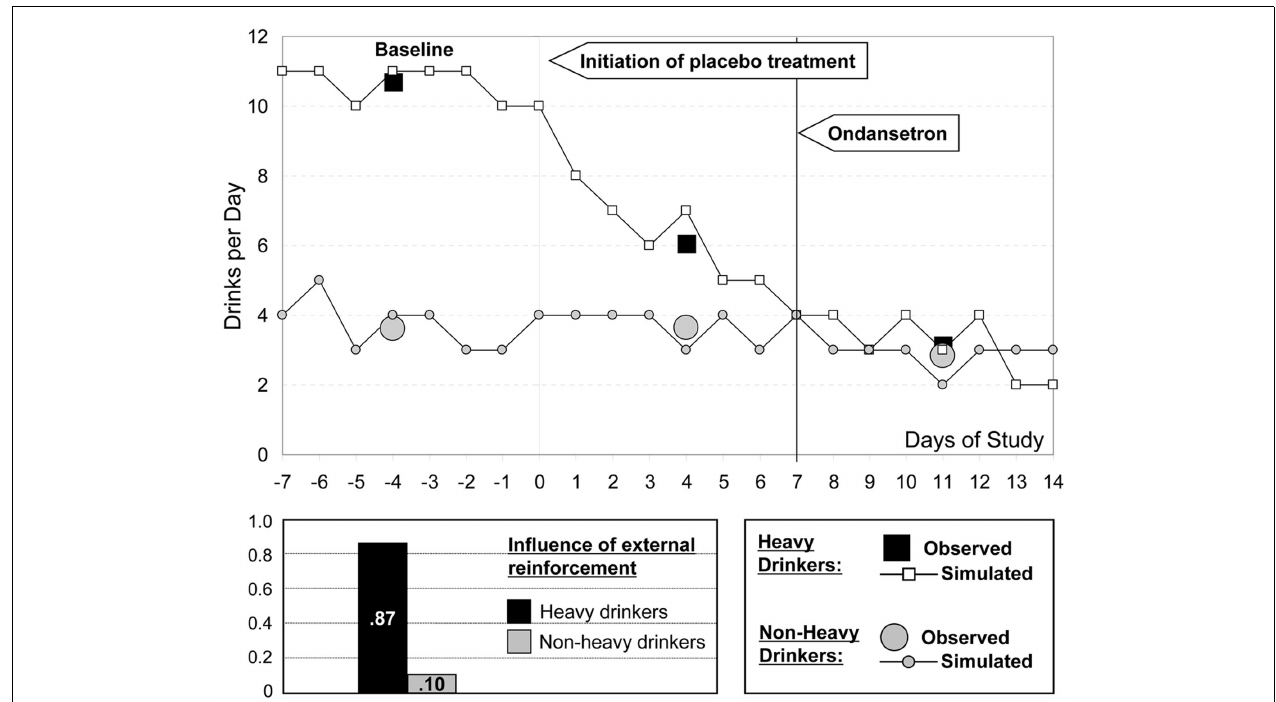
FIGURE 9 | Model-predicted and observed treatment effect in heavy and non-heavy